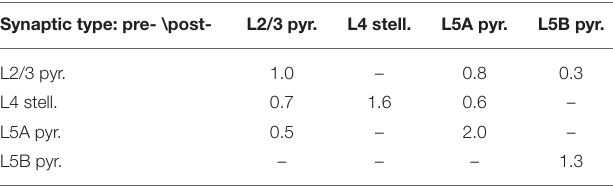
TABLE 3 | Base synaptic conductance values for connections between different types in units of nS. Synaptic type: pre- \post-